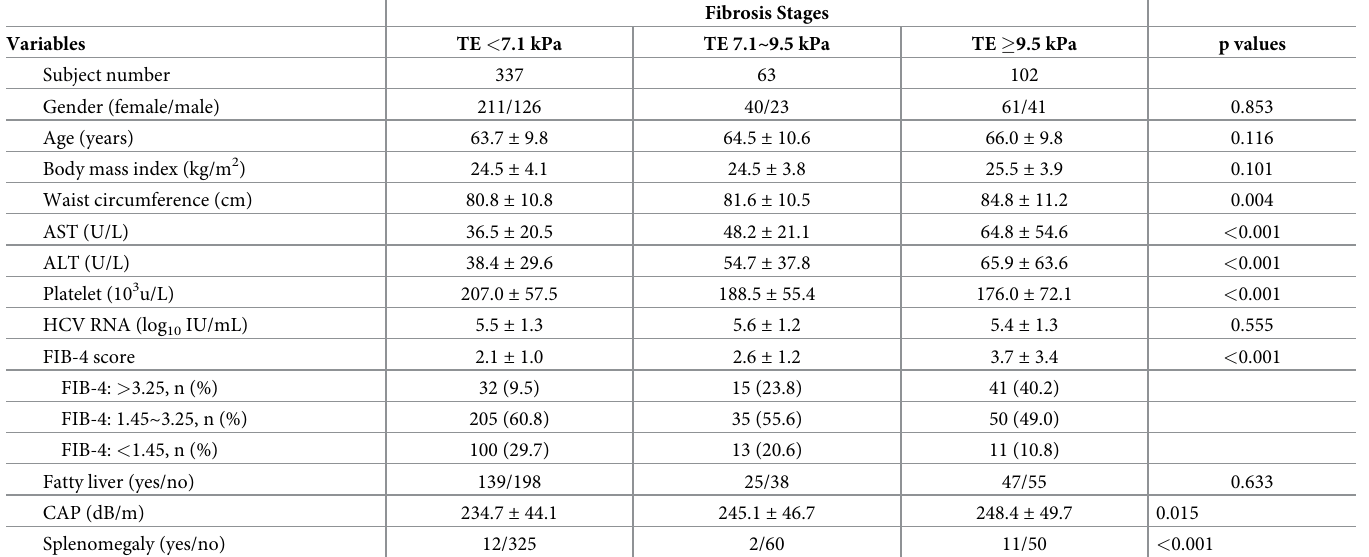
Table 4. Comparisons of characteristics of fibrosis stages by transient